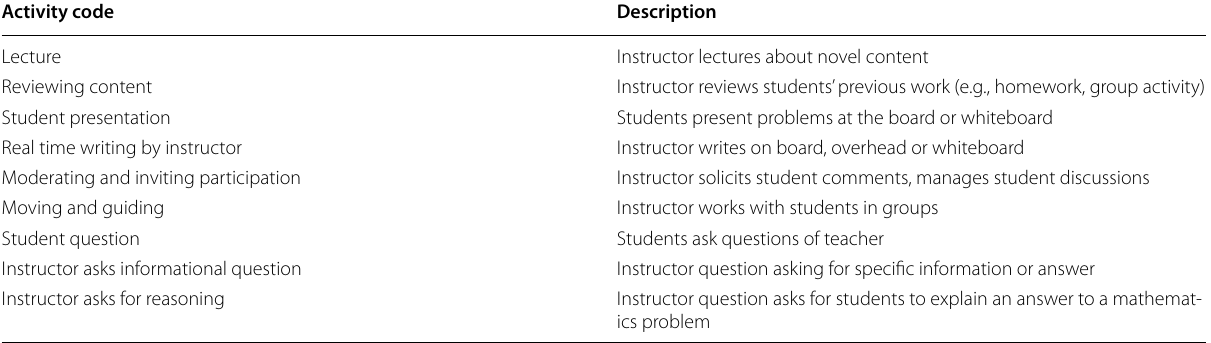
Table 1 Activity codes used in latent profile analysis